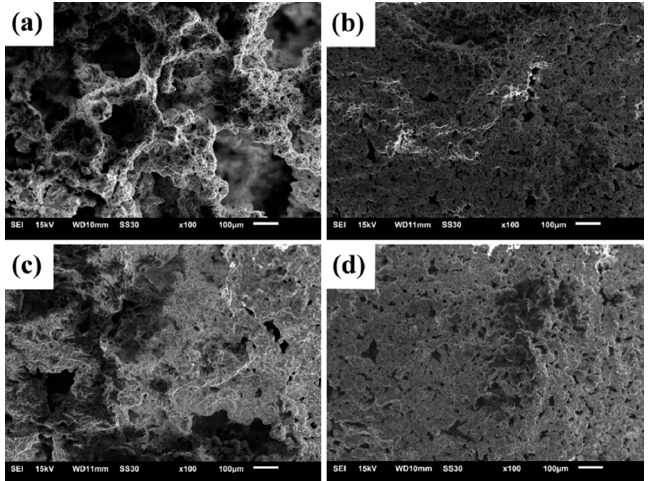
Figure 8. Surface images of samples: EPDM/AF 0 after firing at 600 °C ( a ) and 800 °C ( c ); EPDM/AF 10 after firing at 600 °C ( b ) and 800 °C ( d ).